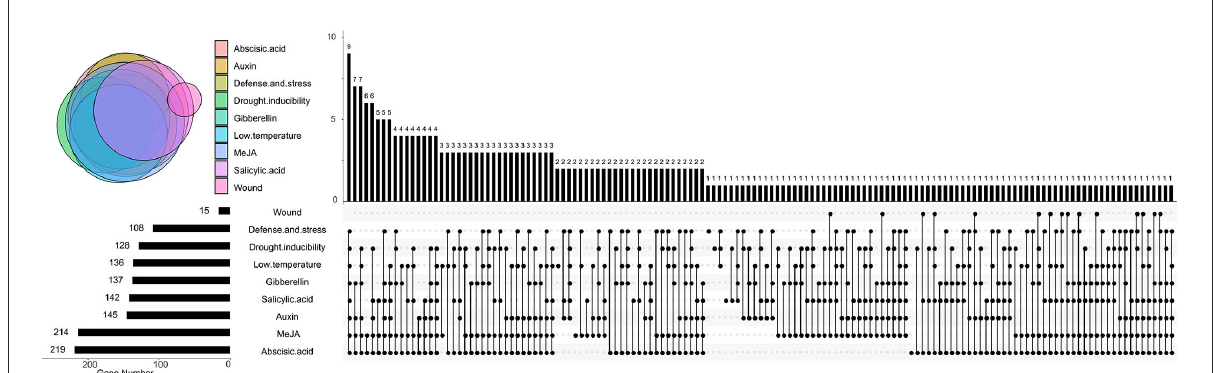
FIGURE5 Distributions of cis -acting elements in BnRLP promoter. The Upset plot shows the distribution of cis -acting elements in BnRLP promoter. The bar chart above represents the number of genes contained in each type of RLP. The bar chart at the bottom left represents the number of genes included in each type of cis -acting element. The dotted line shows the types of cis -acting elements contained in the